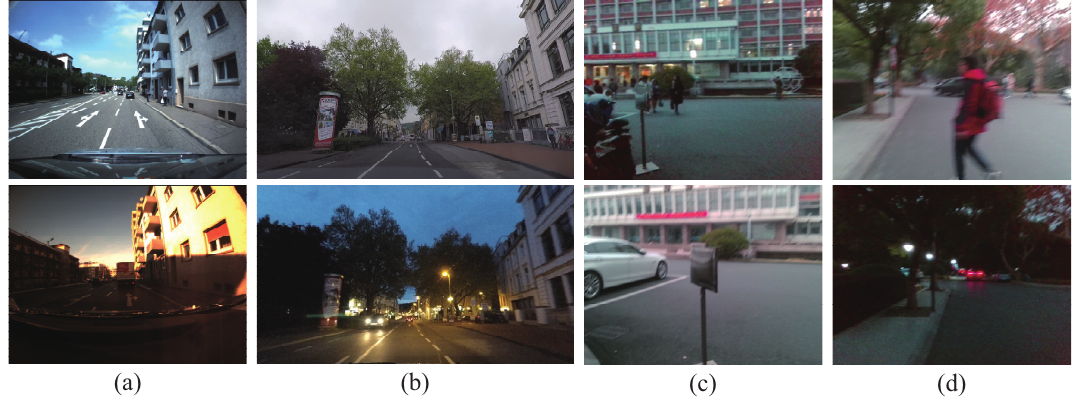
Figure 1. The exemplary query images (the upper row) and corresponding database images (the lower row) in: ( a ) Bonn dataset [8]; ( b ) Freiburg dataset [9]; and ( c , d ) the customized